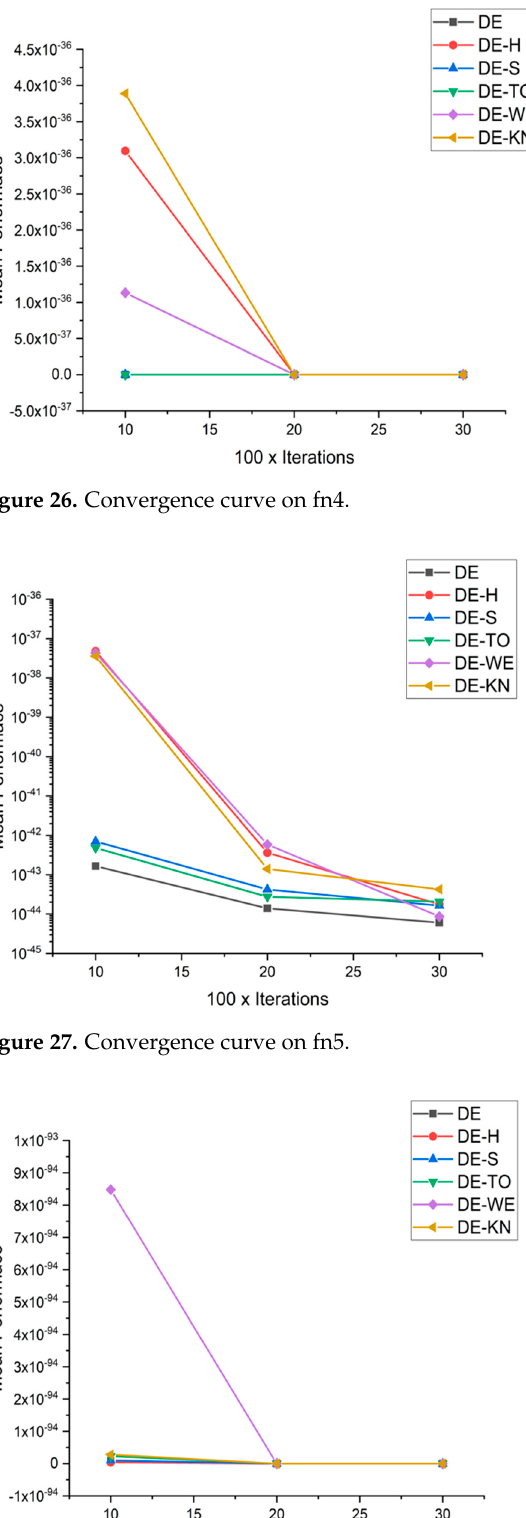
Figure 25. Convergence curve on fn3.